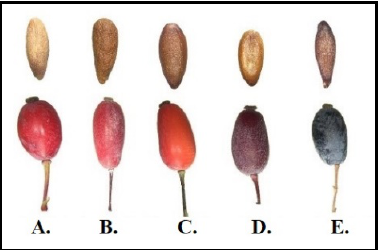
Figure 4. The fruits and seeds of Berberis spp. ( A ) B. vulgaris L., ( B ) B. vulgaris L. *, ( C ) B. integerrima Bunge, ( D ) B. integerrima × B. crataegina **, ( E ) B. crataegina DC., * Culture plant ** Hybrid.